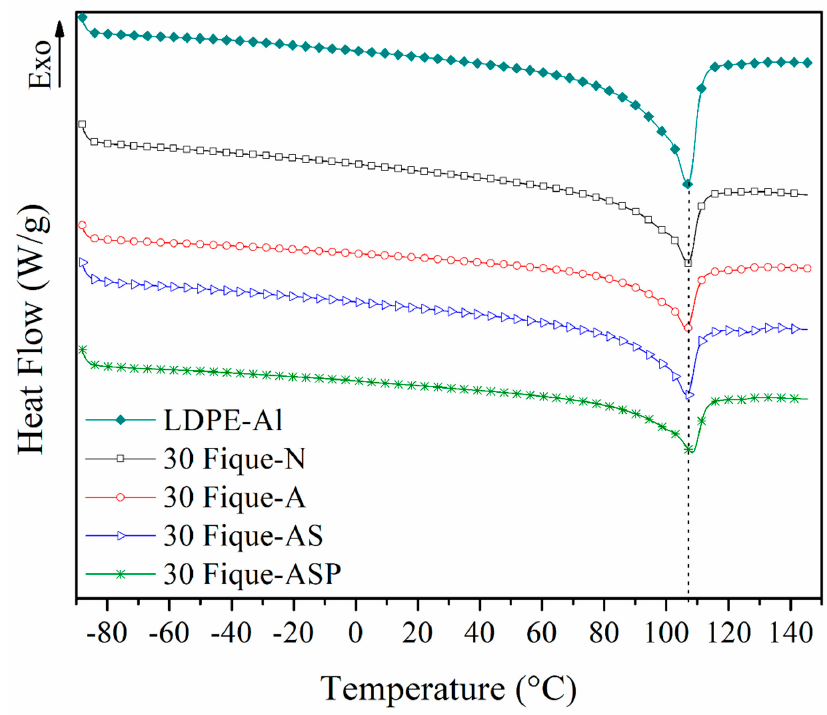
Figure 7. Heat flow vs temperature for LDPE-Al and composites with 30% fique fibers with different surface modifications (second heating).